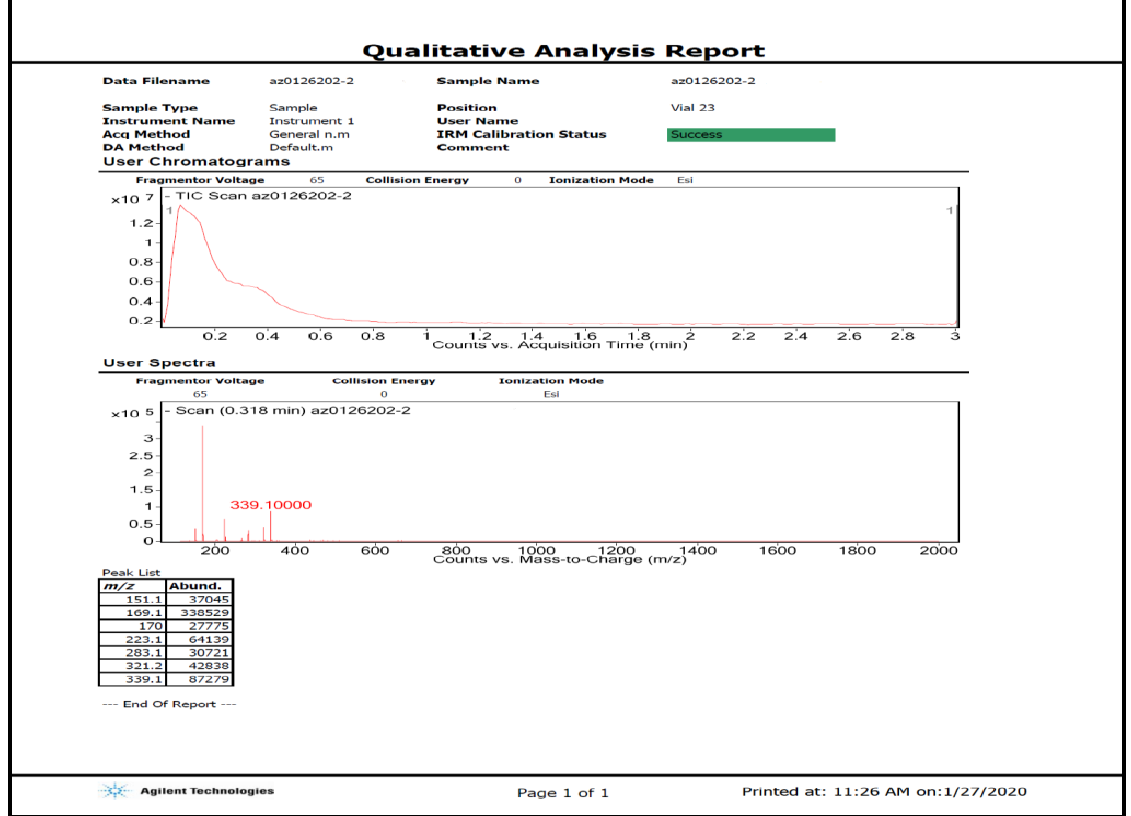
Figure 22. LC/MS chromatogram of isolated compound number 2. Molecular ion peak at m/z 223 that correspond to the molecular formula of C11H12O5 (3,5-dimethoxy-4- hydroxycinnamic acid) sinapic acid.